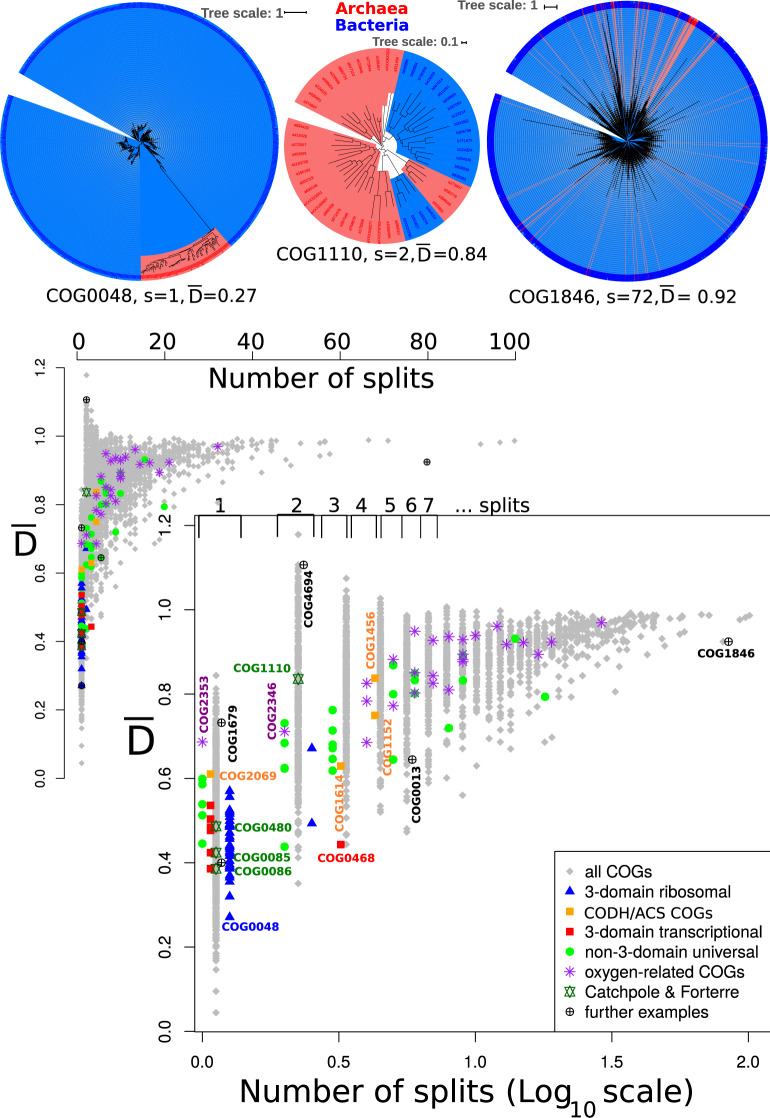
Relationship between the number of archaea:bacteria interdomain branches (splits) and D¯ observed in phylogenetic trees drawn from the COGs. Top: Reconstructed trees for COG0048 (ribosomal protein S12), COG1110 (reverse gyrase), and COG1846 (DNA-binding transcriptional regulator, MarR) with corresponding interdomain archaea:bacteria branches (splits) (s) and D¯ values. The position of these trees is indicated in part B of the figure. The trees are drawn shading archaea in red and bacteria in blue , and the branch lengths are contained within the shaded region. Bottom: Interdomain split values for each COG plotted against D¯, where lower D¯ values represent phylogenetic trees with smaller average intra- to inter-domain phylogenetic distances. The inset shows the distribution on normal scale, and the log (split) version is shown below. Symbols are slightly shifted to avoid overlays, and the differently shaped and colored symbols indicate subgroups as defined by Harris et al. (2003), Catchpole and Forterre, oxygen related COGs (Liu et al. 2018), CODH/ACS COGs, and further examples as indicated in the legend. Brackets on top of the log-plot summarize regions in the plot that correspond to 1, 2, … splits. Labeled symbols refer to corresponding reconstructed phylogenetic trees shown in (top), in supplementary figure 5 and additional table 2, Supplementary Material online. COG0013 is the alanyl-tRNA synthetase, and COG1679 is a predicted Fe-S cluster binding aconitase.